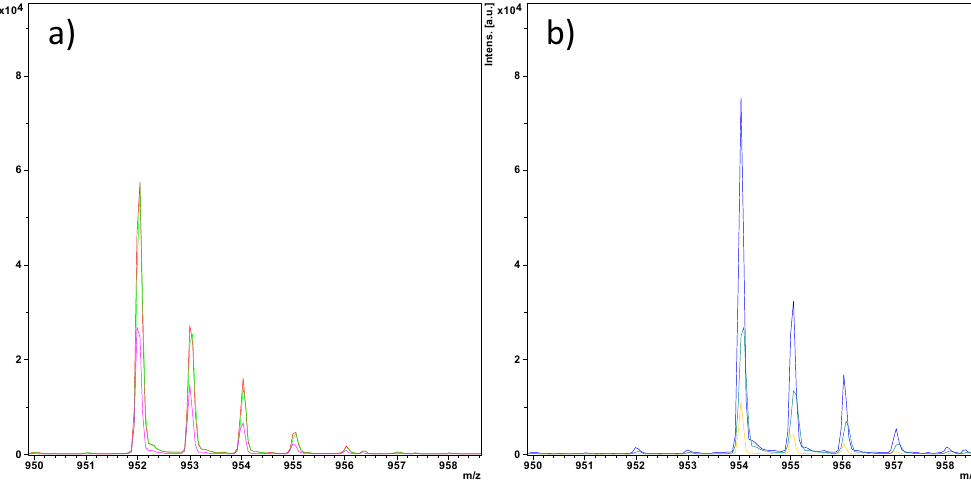
Figure 5. Peptide 1 before ( a ) and after 5 min ( b ) incubation with DTT. The higher molecular weight shows a full reduction of peptide 1 to the linear counterpart of (CTVRTSADC) within 5 min.